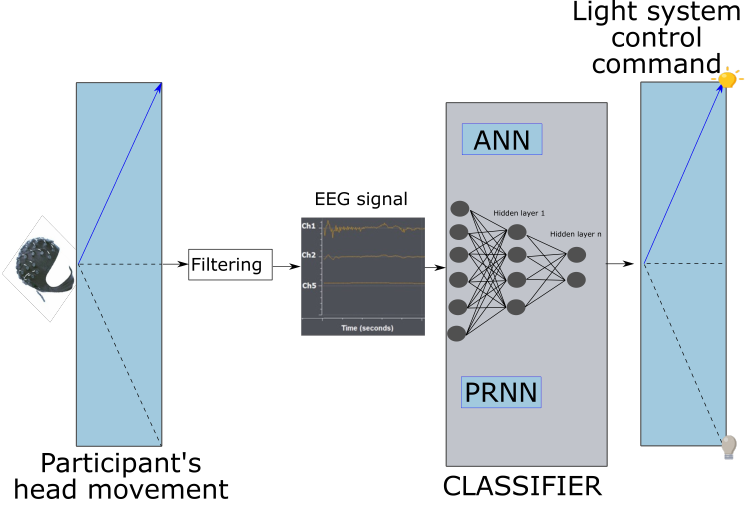
Figure 5. Binary controller